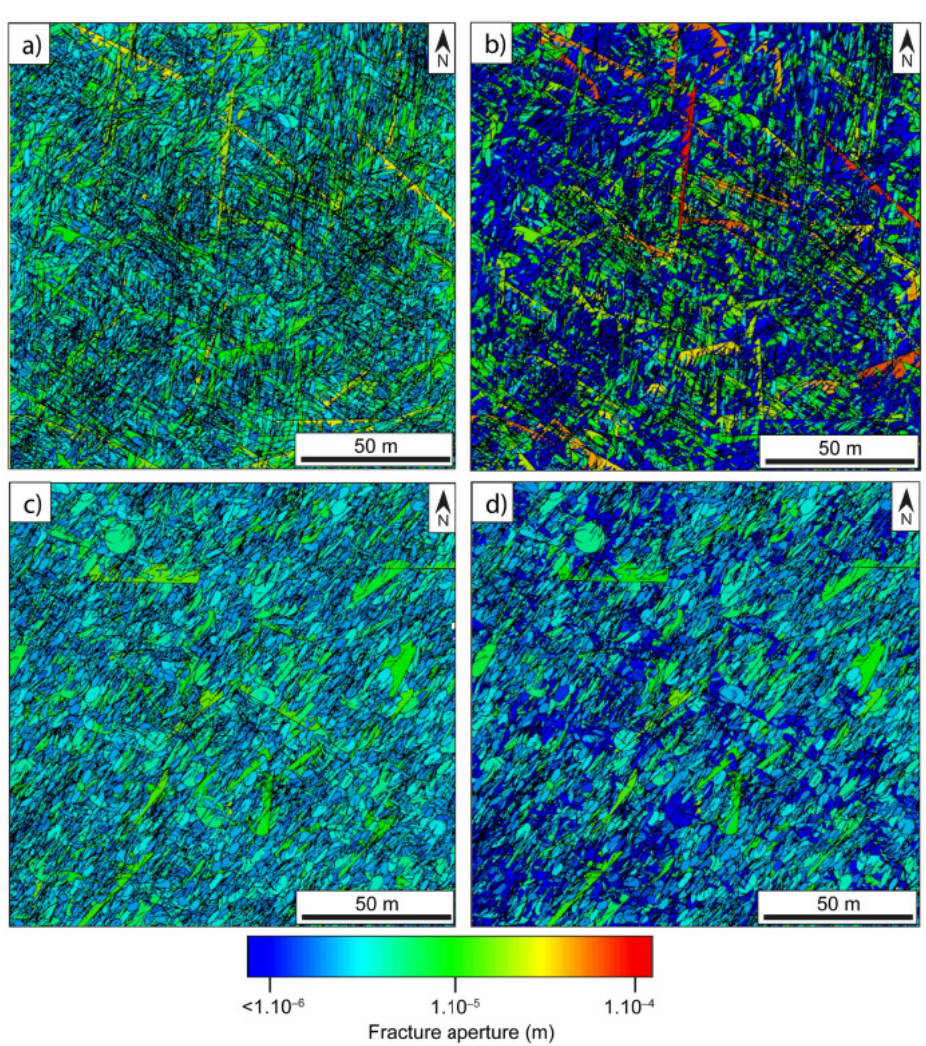
Figure 7. Fracture aperture maps for ( a ) DFN case 1, 10% of open fractures, andfracture length dependant aperture and ( b ) DFN case 1, 10% of open fractures, and shear dependent aperture, and ( c ) DFN case 2, 10% of open fractures, andfracture length dependant aperture and ( d ) DFN case 2, 10% of open fractures, and shear dependent